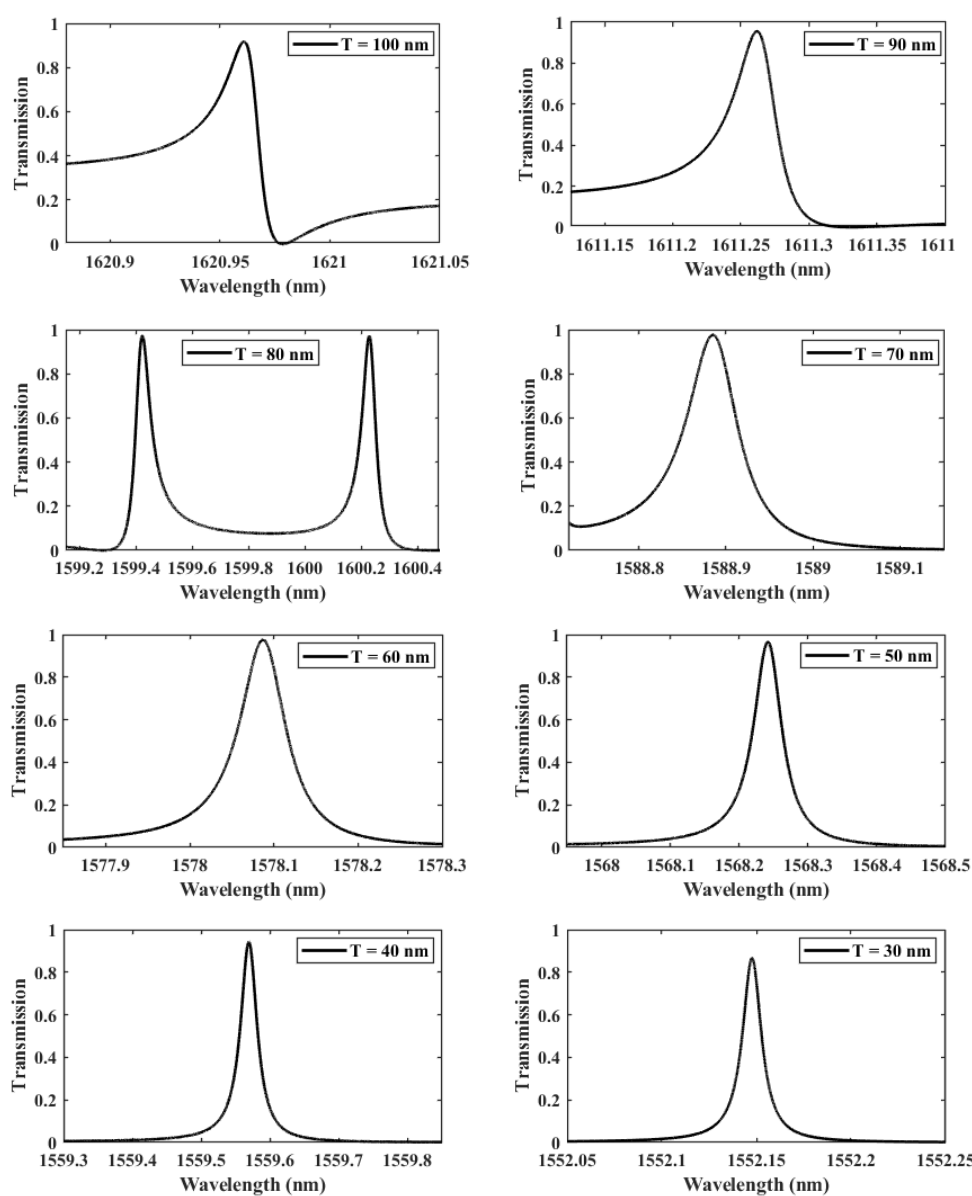
Figure 4. The evolution of Fano resonance transmission patterns as the gap separation T is spanning from 100 to 30